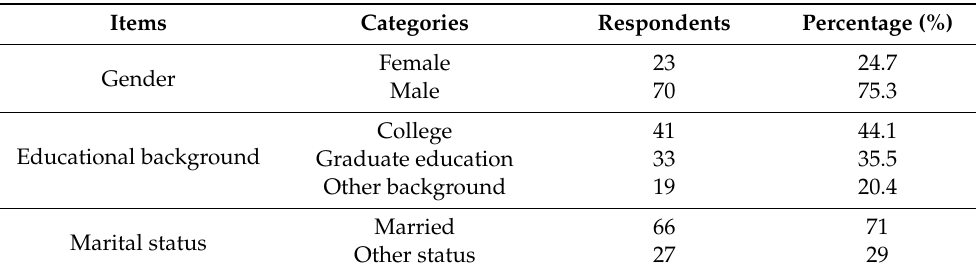
Table 2. Sample distribution of Study